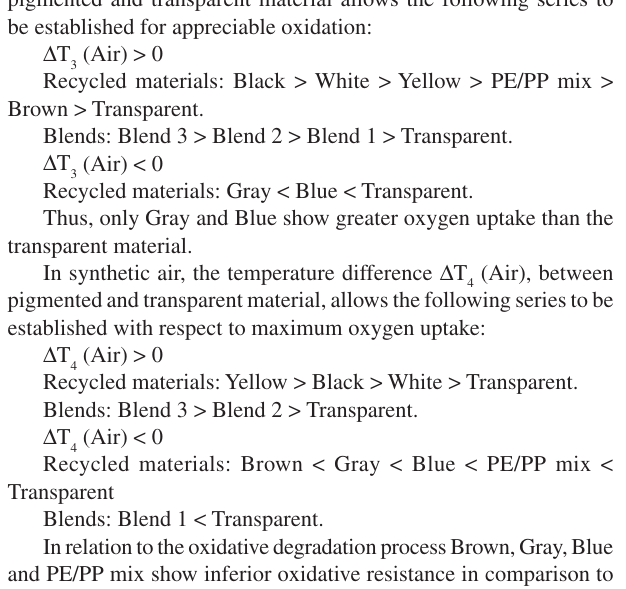
transparent material; ∆ T 2 = T pigmented material – T 4 4